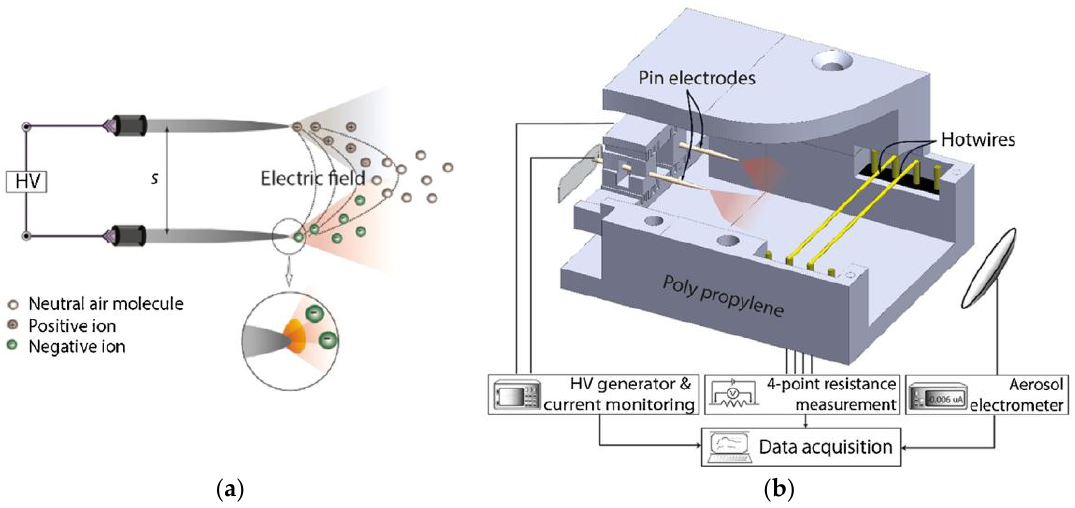
Figure 14. ( a ) Schematic view of bipolar corona discharge enhanced air flow; ( b ) Schematic design of device and measurement setup: a battery operated high voltage generator is connected to parallel pin electrodes and the ion wind is measured by hotwires heated by constant current